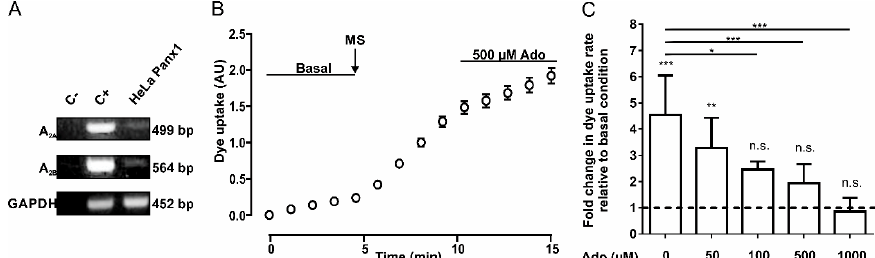
Figure 1. Adenosine reduces the activity of Panx1 channels. ( A ) RT-PCR of A 2A and A 2B adenosine receptors in HeLa Panx1 cells. The PCR reaction without template DNA was used as a negative control (C-) and the Jurkat cell cDNA was used as a positive control (C+). GAPDH was used as a constitutive expression control and its amplicon of 452 bp was used as loading gel control. ( B ) Time course of DAPI uptake in HeLa Panx1 cells at basal condition, after mechanical stretch (MS, the arrow indicates when it was applied) induced by dropping 6 mL, and during treatment with 500 µM adenosine (Ado). ( C ) Normalized dye uptake rate in HeLa Panx1 cells after mechanical stretch and subsequent treatment with different concentrations of adenosine. Statistical analysis was performed between each experimental group (connecting lines) and comparing each group with baseline (symbols above each bar). Note: * p < 0.05, ** p < 0.005, *** p <0.001; n.s., not significant. Each value corresponds to the average ± standard error of a total of three to seven independent experiments.